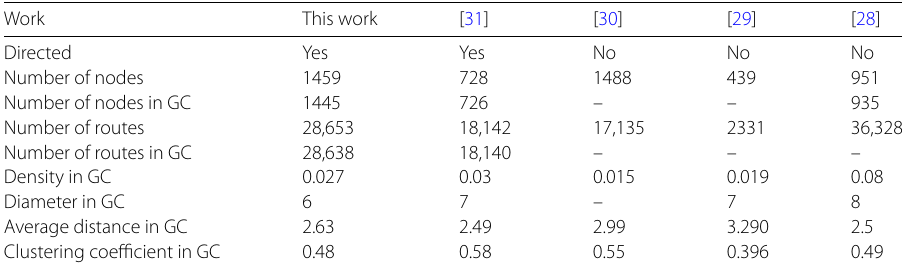
Table 1 General properties of the considered cargo ship network used in this work, compared to others reported in literature. GC denotes the giant component (largest connected component). In case of directed networks we report on the largest strongly connected component Work This